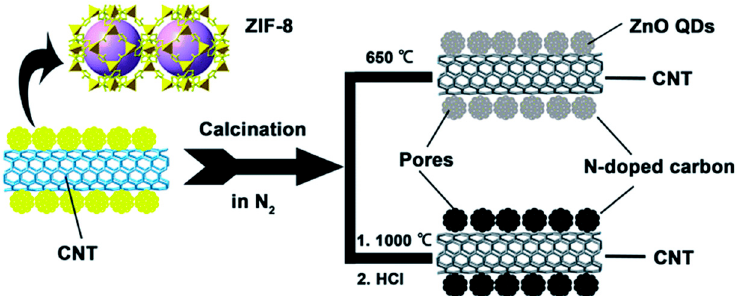
Figure 15. Fabrication process of single-templating approach for ZnO QDs/carbon/CNTs//N-doped carbon/CNTs ASC [203].